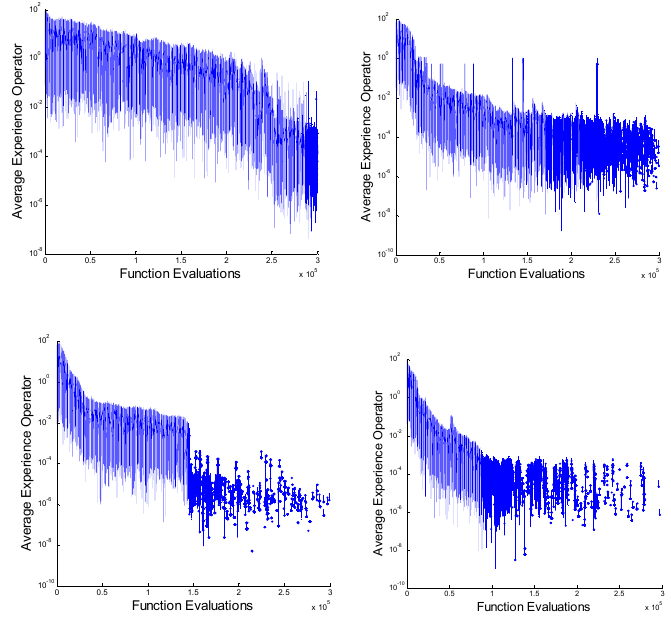
Figure 2. Change of Experience Operator on aHSDE (f1, f10, f21, f28).